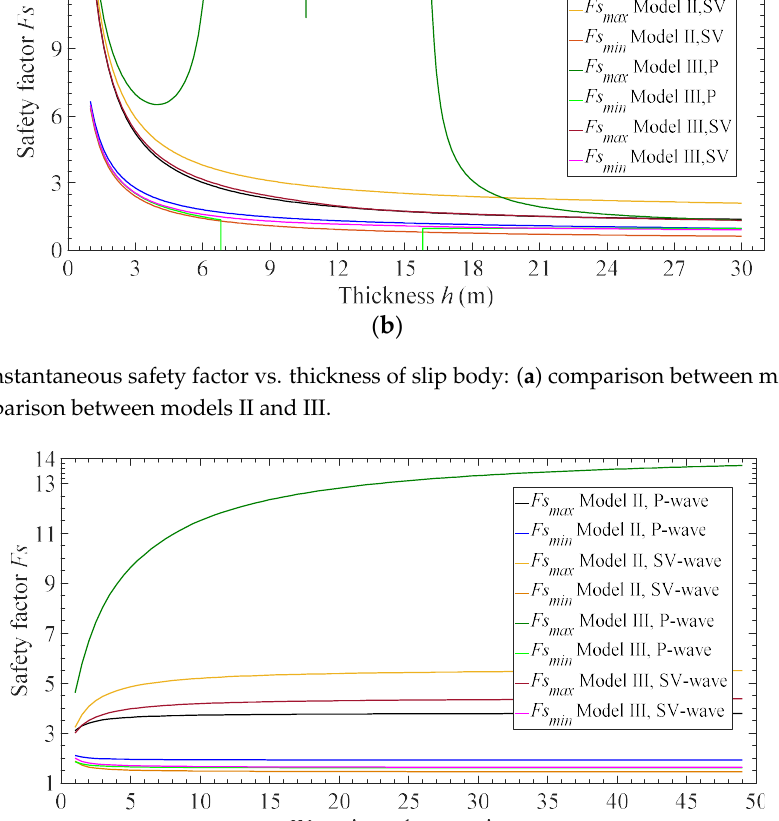
Figure 5. Instantaneous safety factor vs. wave impedance ratio